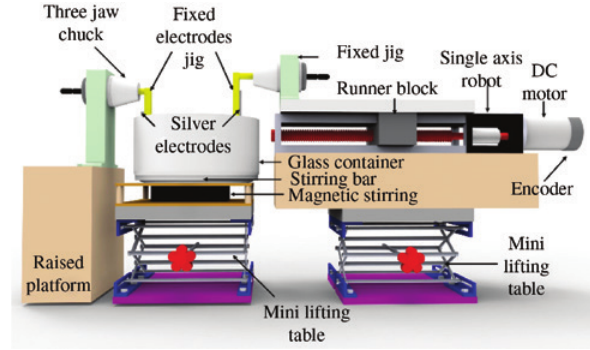
Figure 3: The micro-EDM system.